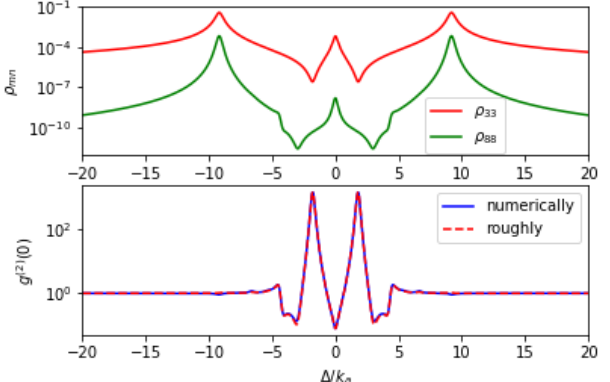
Figure 4. Plots of the density matrix element ρ 33 , ρ 88 and the second-order correlation function g ( 2 ) ( 0 ) as functions of the scaled detuning of Cavity A for ε = 0.1 κ a and g = 1.8 κ a . Other parameters are the same as in Figure 3.